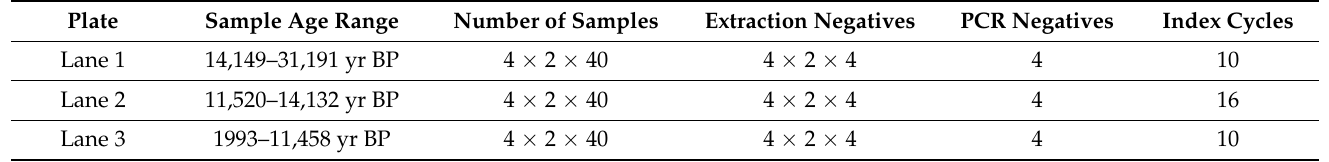
Table A3. Metabarcoding plate